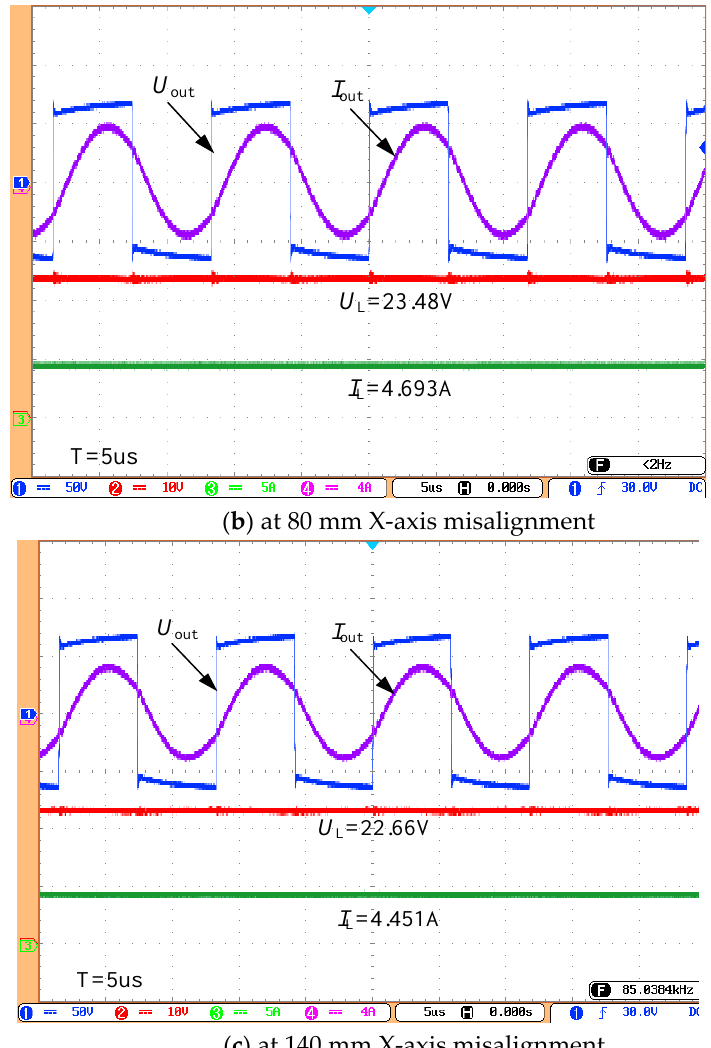
Figure 11. Experimental waveforms at R L = 5Ω.